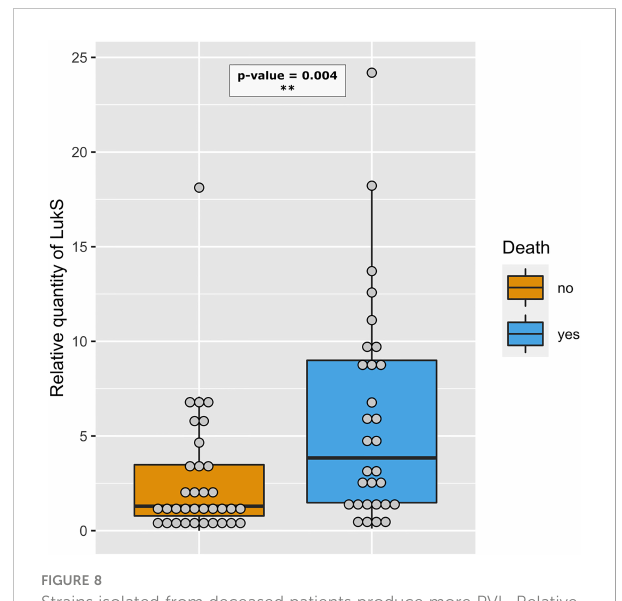
FIGURE 8 Strains isolated from deceased patients produce more PVL. Relative amount of LukS from PVL-positive strains isolated from deceased (blue, n=30) and non-deceased (orange, n=34) patients are represented by dot plots. The medians with 25 th and 75 th percentiles are represented by box plots. A logistic regression model including the Charlson Comorbidity Index score as covariate was performed, p-value< 0.01 - **.